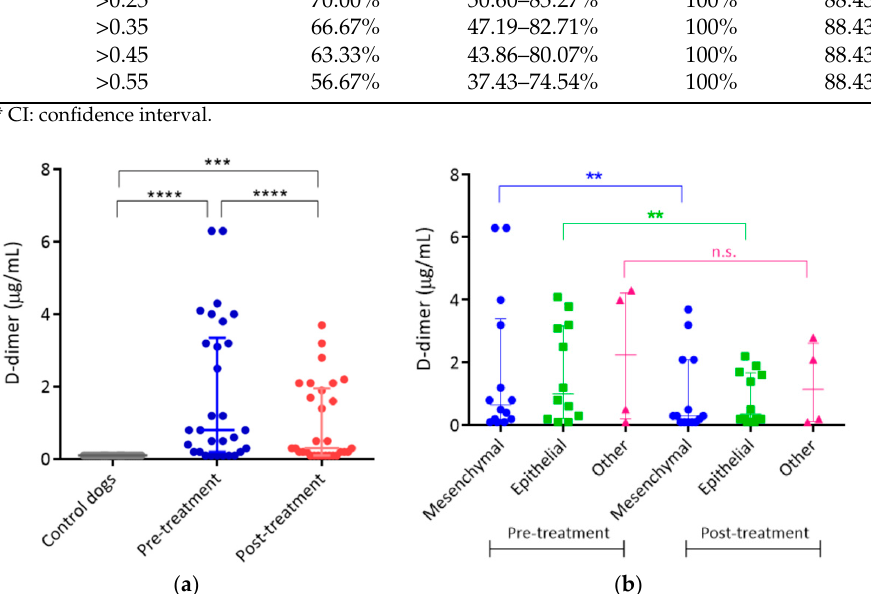
Figure 2. Alteration of D-dimer concentrations in plasma of different types of tumor-bearing dogs before and after treatment. ( a ) The median values of D-dimer are 0.1, 0.8 ± 3.15, and 0.3 ± 1.85 µg/mL in control, pre-treatment, and post-treatment dogs, respectively. The D-dimer values significantly decreased after the operation in all the individuals with tumors ( p < 0.0001) and the values were significantly elevated in dogs with tumors before ( p < 0.0001) and after ( p < 0.001) tumorectomy compared with the control dogs; ( b ) D-dimer significantly decreased in dogs suffering from mes- enchymal (n = 14, p = 0.0039) and epithelial tumors (n = 12, p = 0.0039) after treatment. However, there are no obvious changes in the other dogs with neoplasms (n = 4, p = 0.25). Before treatment,